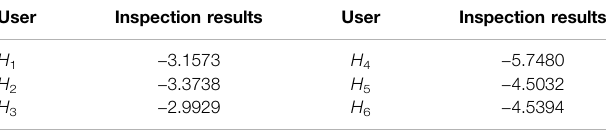
TABLE 2 | Residual sequence smoothness test results of user and loss. TABLE 3 | Granger causality test results of edge